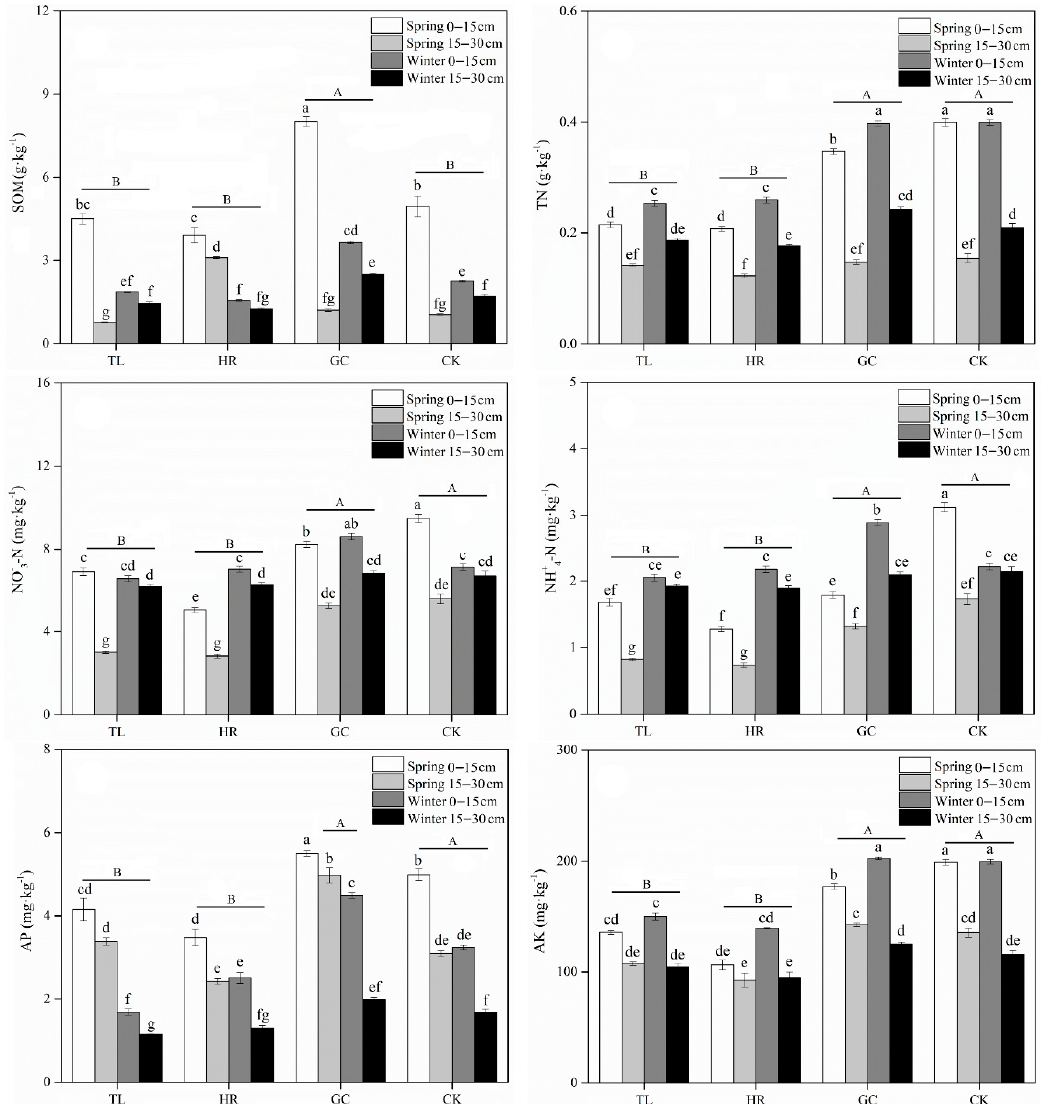
Figure 2. Di ff erences in soil nutrients in the control area and three positions in the subsidence area. Lowercase letters indicate significant di ff erences among samples based on Duncan’s multiple range test ( p < 0.05) while uppercase letters indicate di ff erences among sites. SOM: soil organic carbon; TN: total nitrogen; TP: total phosphorus; AP: available phosphorus; AK: available